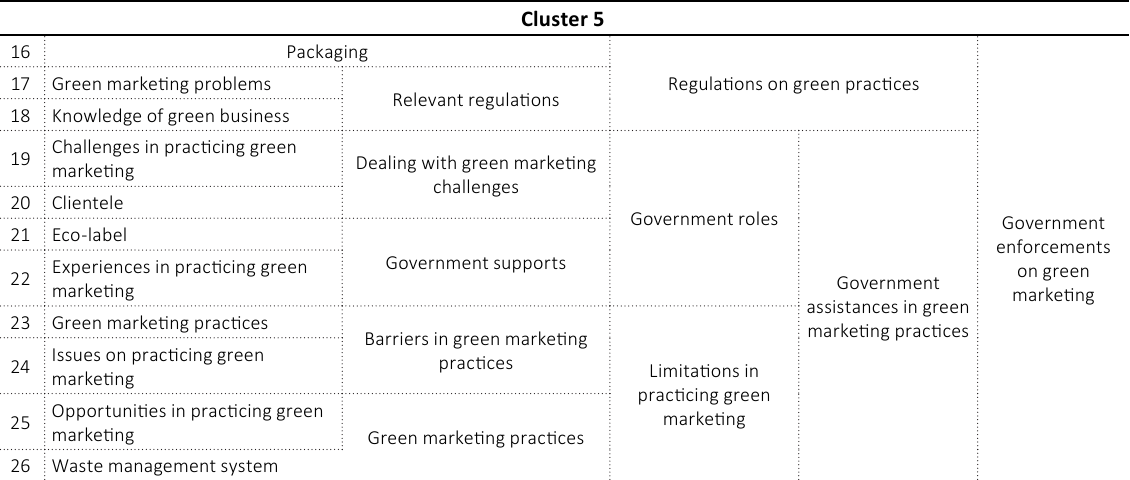
Table 6. Codes comprising Cluster